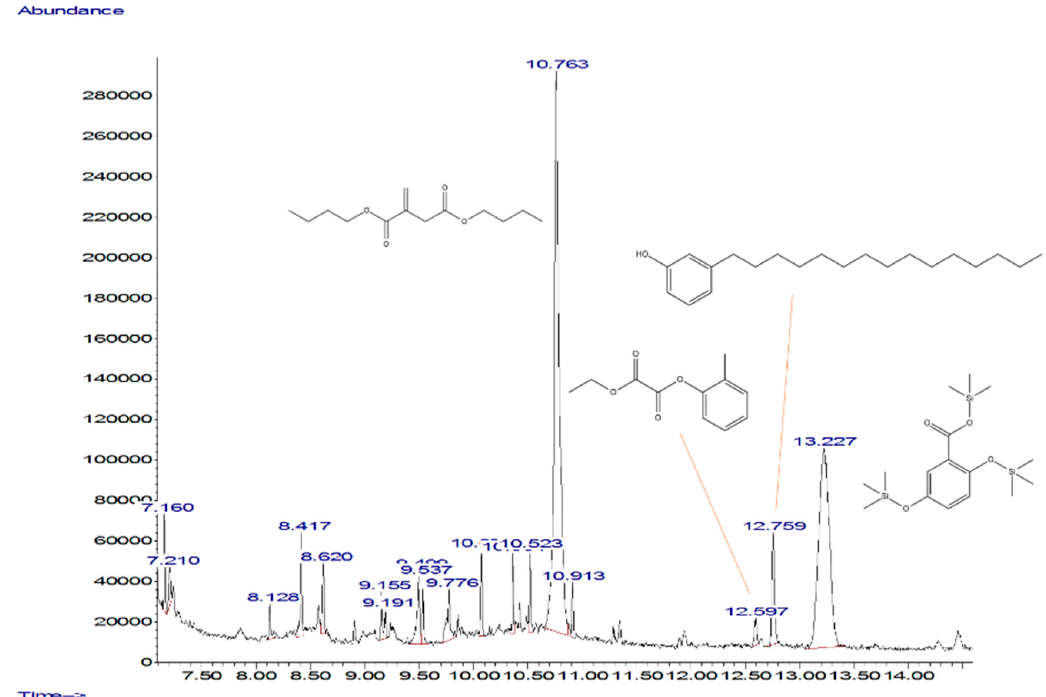
Appl. Sci. 2019 , 9 , x FOR PEER REVIEW Figure A5. GC-MS chromatogram from MW–pistachio hull. Figure A5. GC-MS chromatogram from MW–pistachio hull.